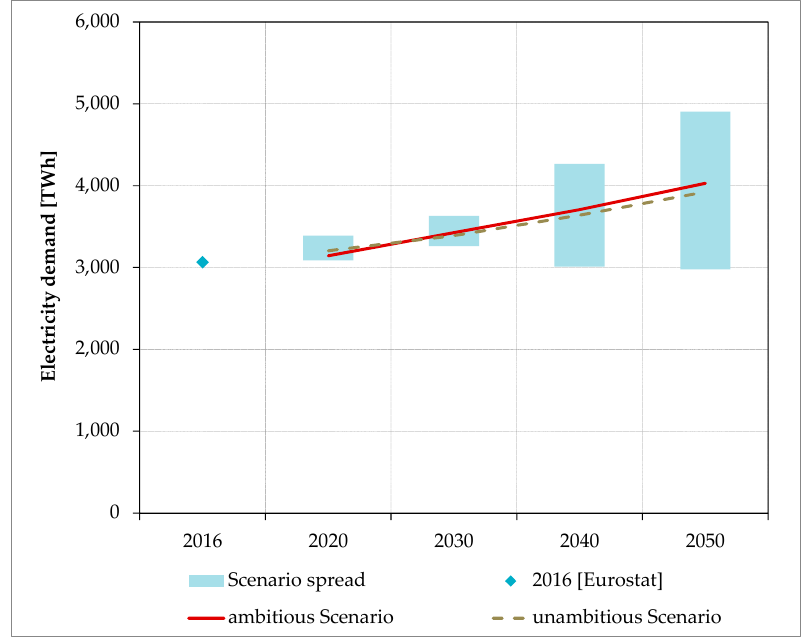
Figure 1. Comparison of annual electricity demand in EU 28 countries based on References [5,29–32].